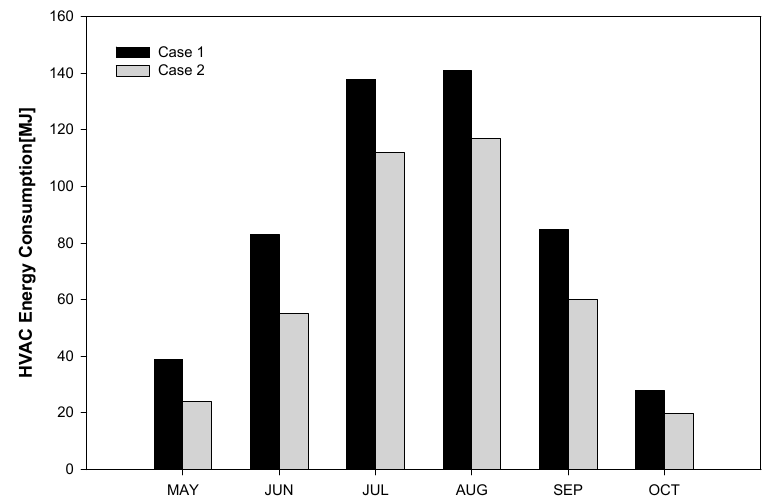
Figure 15. Monthly energy consumption of HVAC.